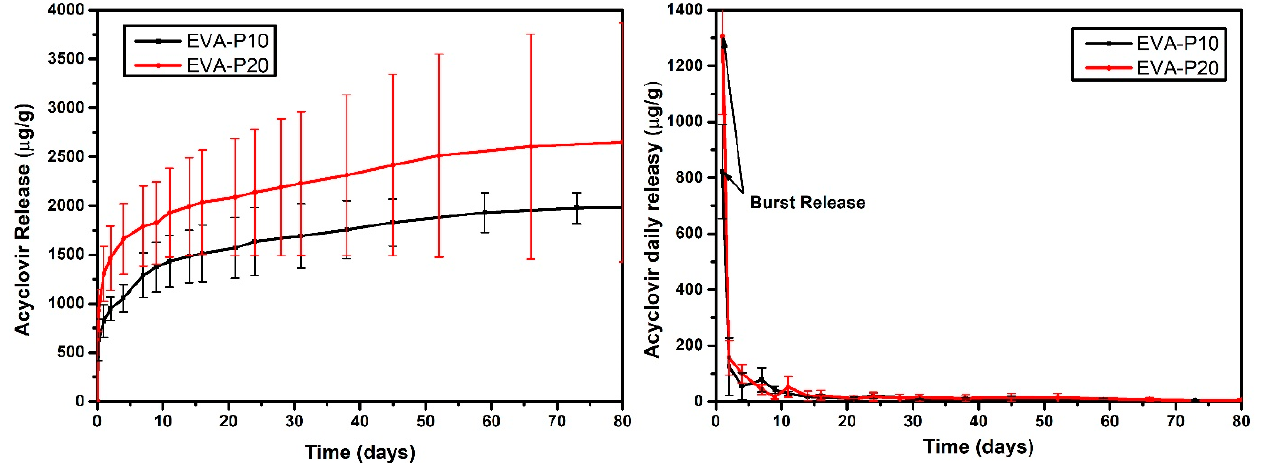
Figure 6. Acyclovir daily ( right ) and accumulated ( left ) release as function of time for EVA-P10 and EVA-P20 samples. EVA-P20